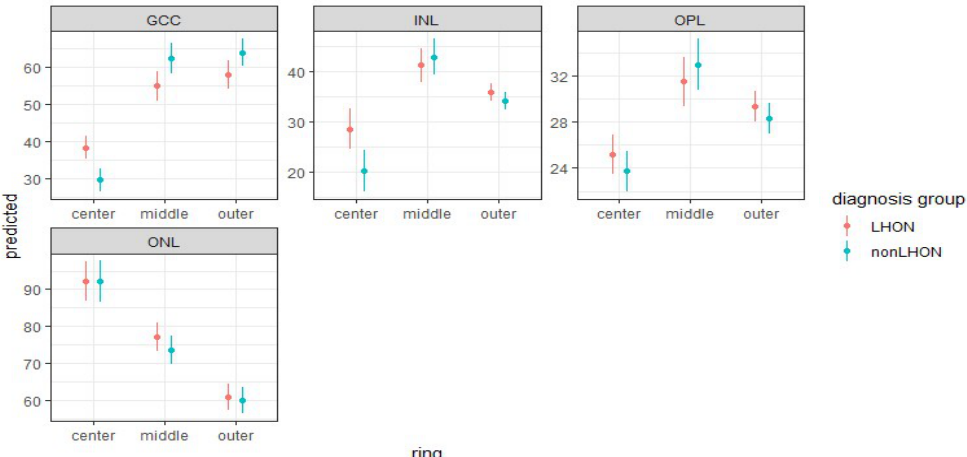
Figure 5. Predicted values for mean thickness (and 95 % confidence intervals) for different retinal layers for LHON and nonLHON group based on full model that includes participants’ ID as a random factor and diagnosis group as a fixed factor. Note thicker GCC layer in the center in LHON group.